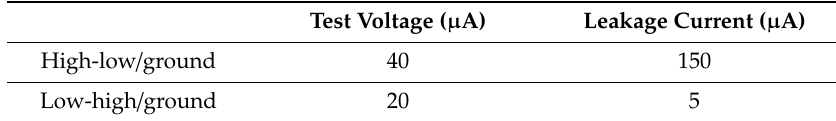
Table 12. DC leakage